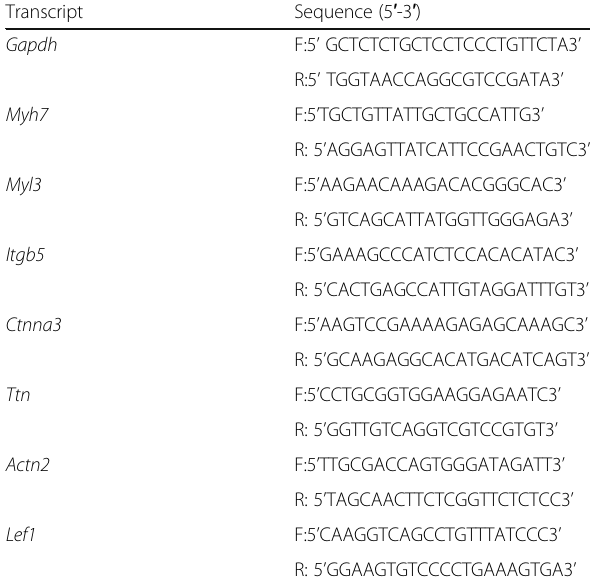
Table 3 Primers used for qRT-PCR analysis